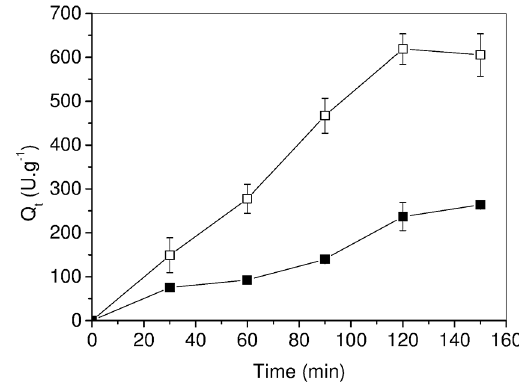
Figure 6: Inulinase adsorption capacity (U.g -1 ) on ZnWO at (⁪) 30 o C and (■) 50 o